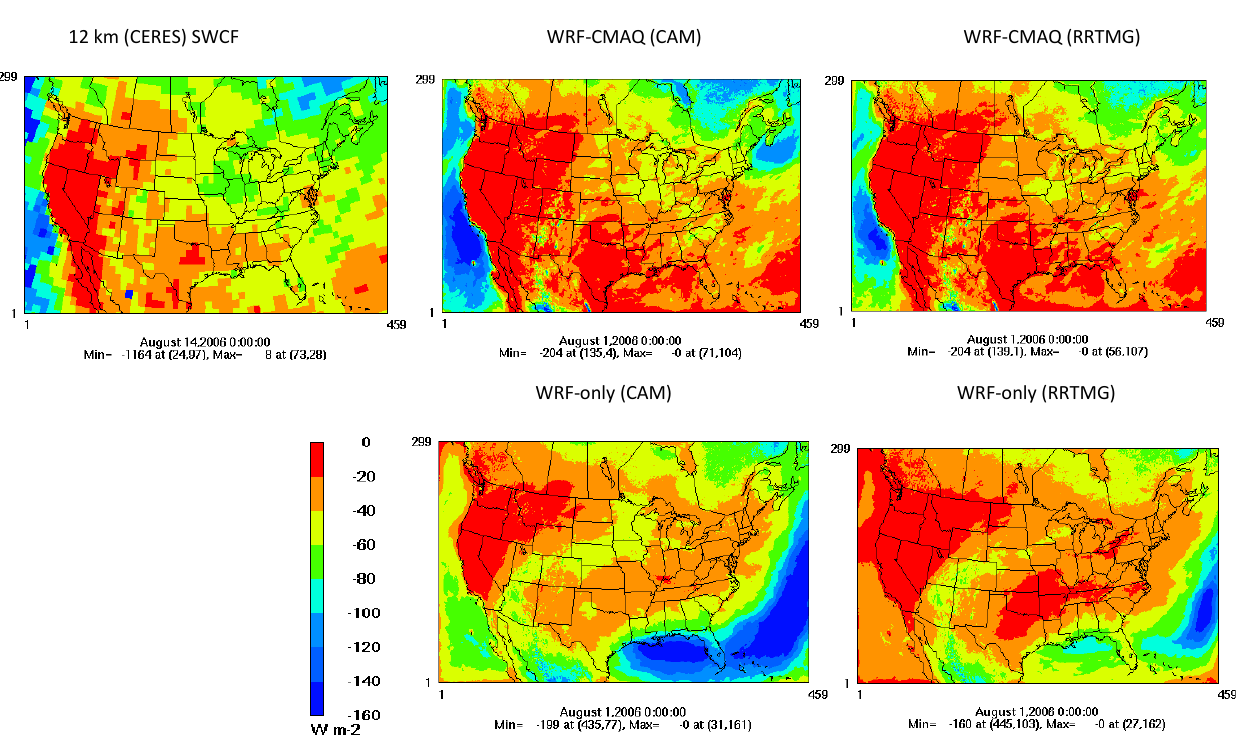
Figure 9. Monthly domain means of SWCF for the CERES observations and model results of WRF–CMAQ/CAM, WRF–CMAQ/RRTMG, WRF-only/CAM and WRF-only/RRTMG on the basis of the 12km resolution simulation over the CONUS for August of 2006